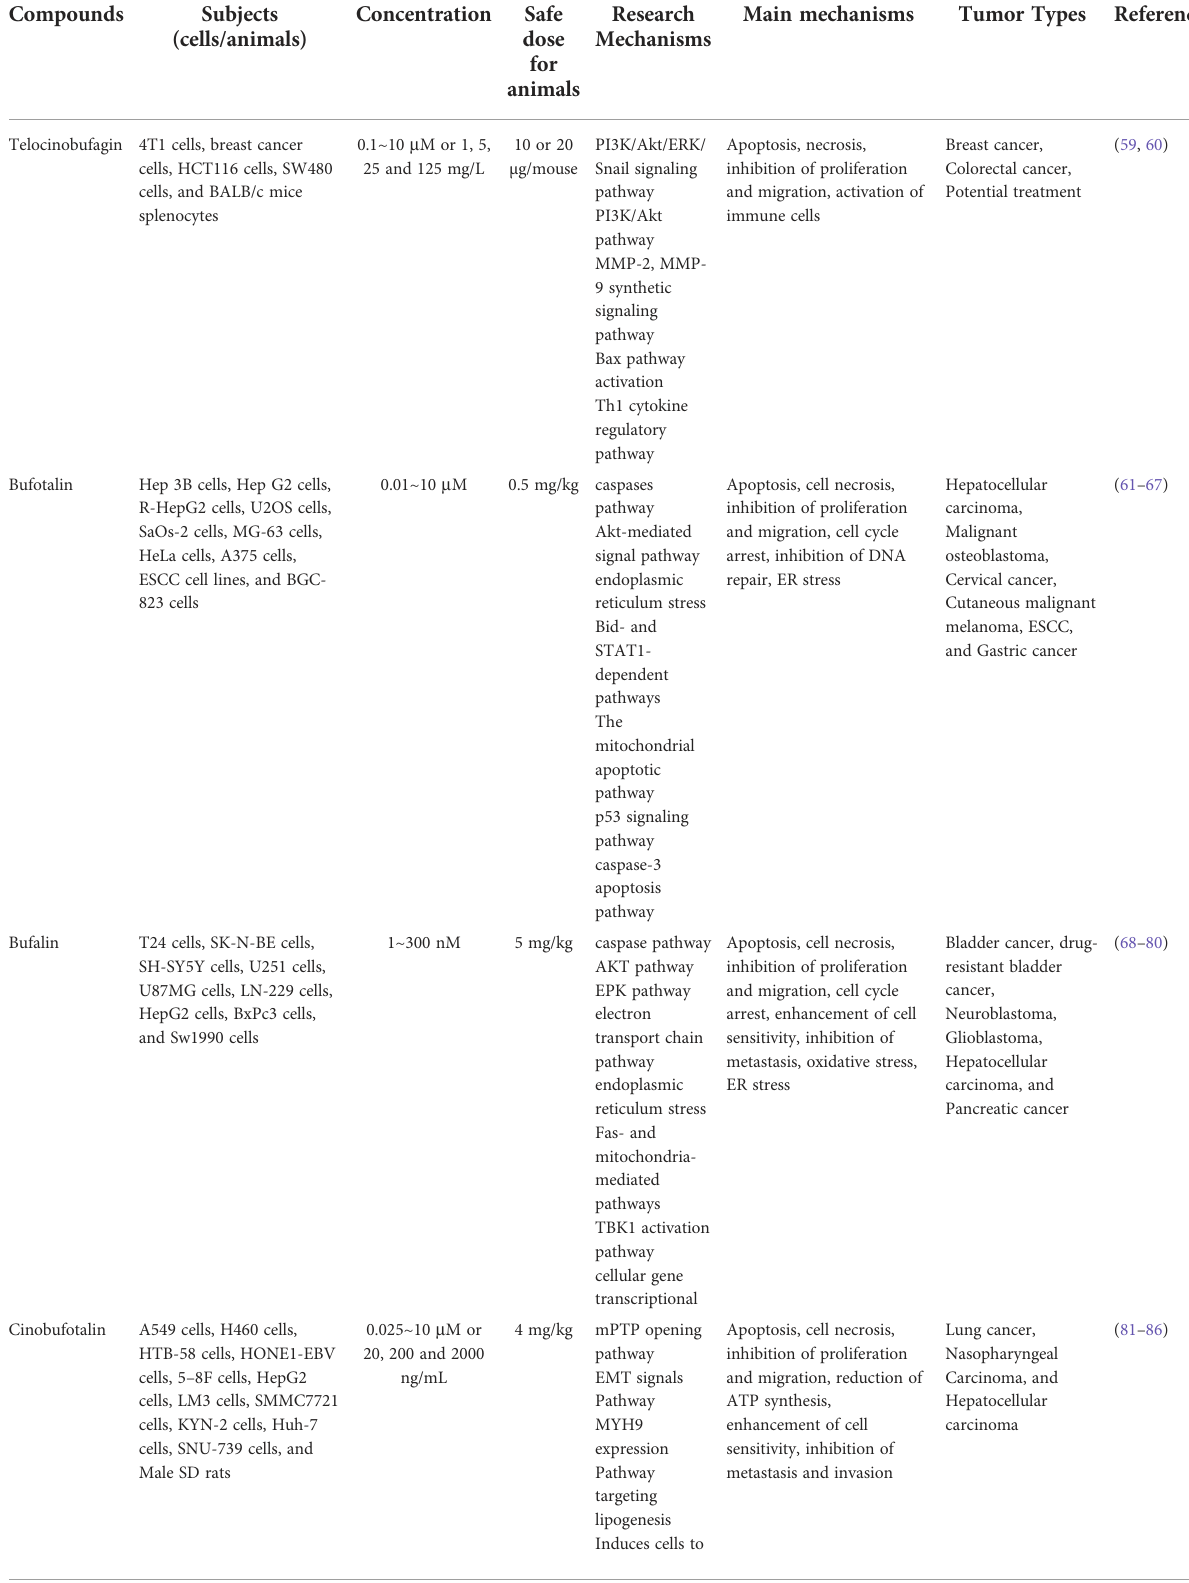
TABLE 1 The antitumor activities and mechanisms of fi ve bufadienolides.